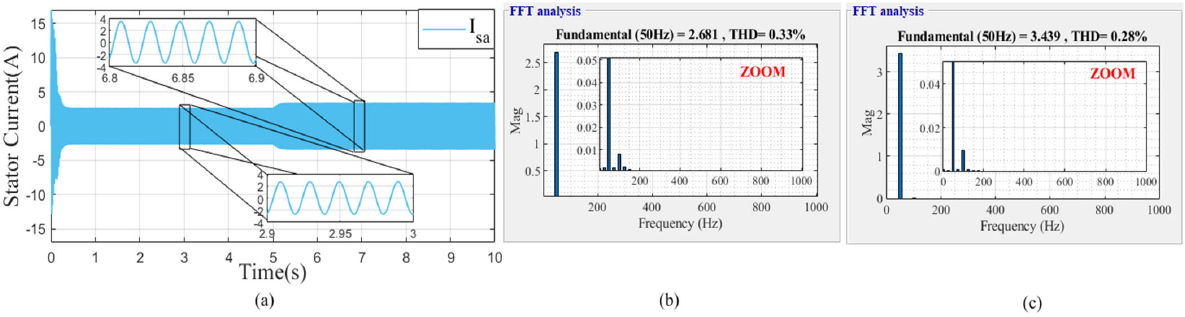
Figure 22. Performance with Ball bearing defect of IM without control: ( a ) Stator current and ( b ) THD at no ‐ load and ( c ) THD with load (5 Nm).